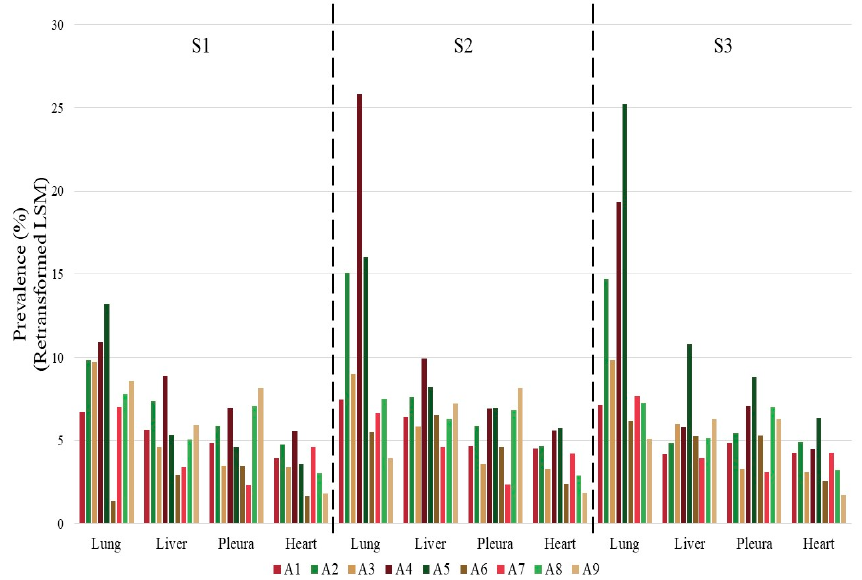
Figure 3. Prevalence (%) of each abattoir (A1–A9) and organ for the respective six ‐ monthly period (S1–S3), based on the retransformed least square means (LSM) of the model. (S1–S3), based on the retransformed least square means (LSM) of the